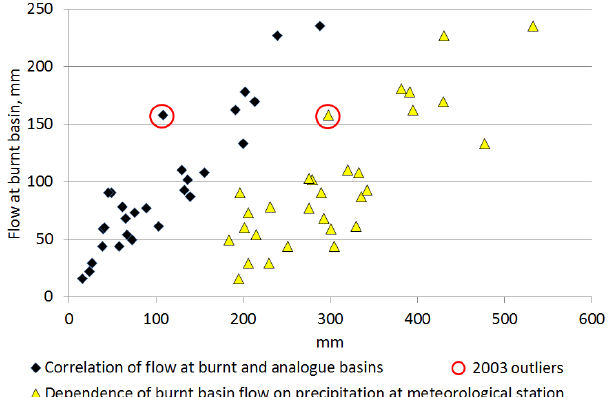
Figure 2. The dependence of summer (June–September) flow at burnt and analogue basins; the dependence of summer flow at burnt basin on summer sum of precipitation at nearest meteorological station during stationary conditions and the dependences outliers caused by fire. Here burnt basin: Amalat River at Ust’-Antose (3130), analogue basin: Amalat River at Rassoshino (3131) and me- teorological station – Ust’-Antose. 1966–1990 and